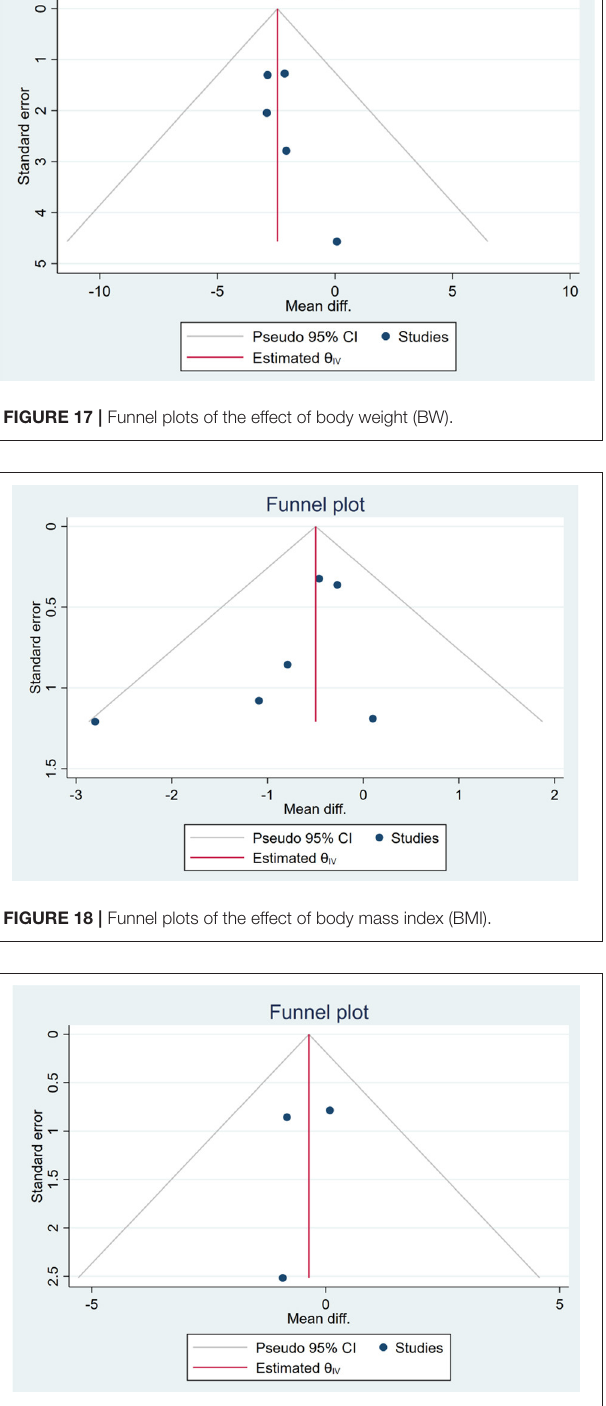
FIGURE 19 | Funnel plots of the effect of waist circumference